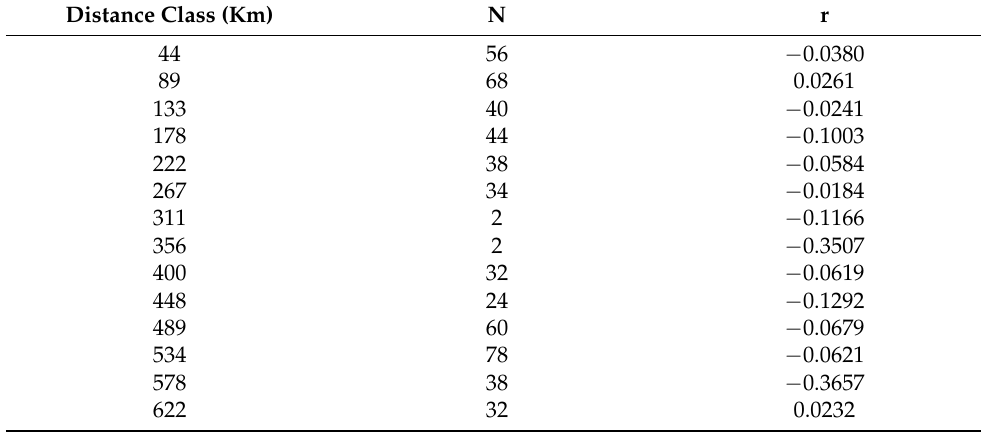
Figure 4. Mantel test between geographical distances and F ST /(1 − F ST ). (r = 0.0145, p = 0.4). Table 5. Correlation coefficient based on the geographic distance of 24 S. litura